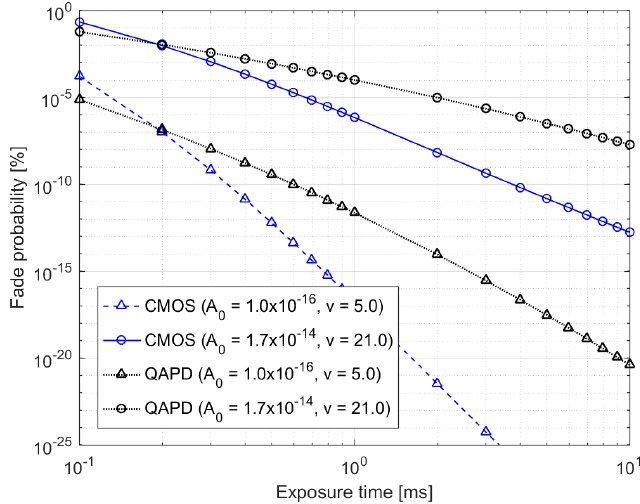
Figure 7. Fade probability versus exposure time under two atmospheric turbulence conditions.